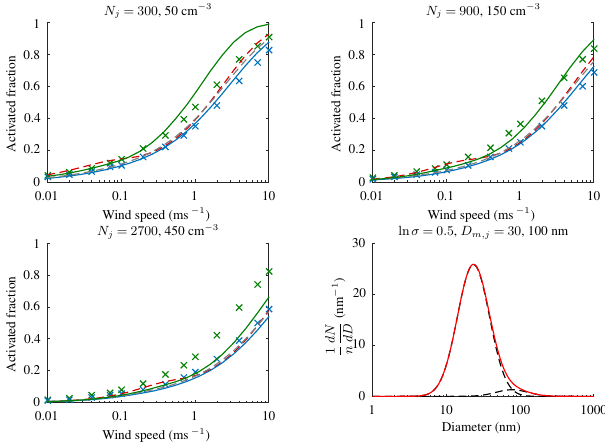
Figure 3. Fraction of total aerosol particles that activate into cloud droplets at a range of vertical updrafts and number concentrations. The solid lines show the results from the parameterisation and the crosses show the parcel model results, while the effect of the SVOCs is shown in green and blue shows the analogous results without the organic vapours. The red dashed lines show the effect of applying equilibrium absorptive partitioning at cloud base and the dashed grey line shows the results of only including the initial condensed concentration of SVOCs. The shape of the size distribution of am- monium sulfate is shown in the lower right plots with median di- ameters and geometric standard deviations written above. Number concentrations used are specified above each